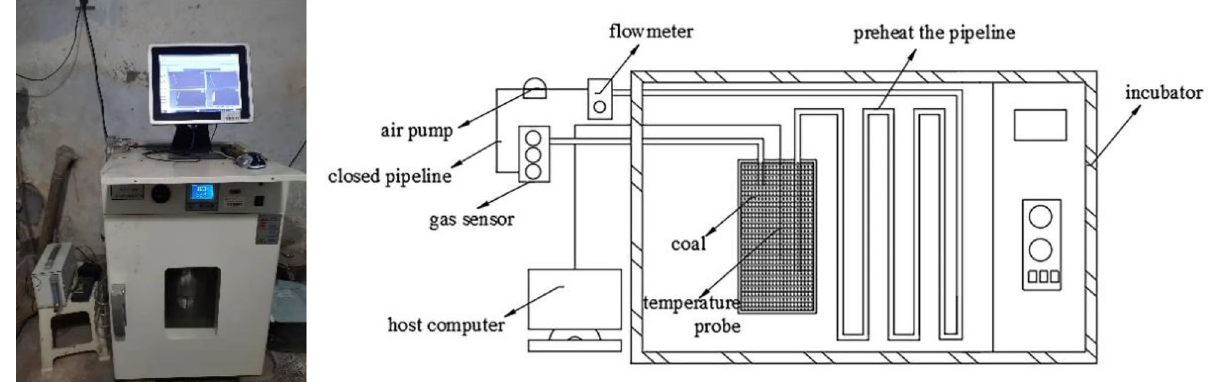
Figure 1. Closed oxygen consumption experimental